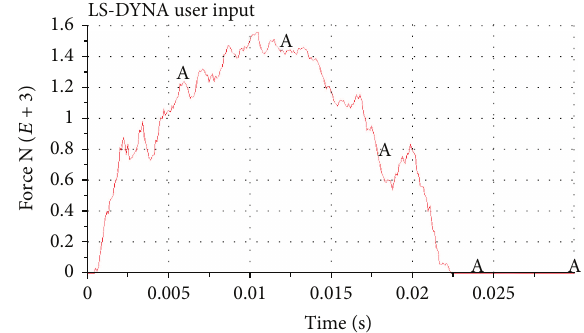
Figure 6: Simulated impact force of rubber ball with respect to